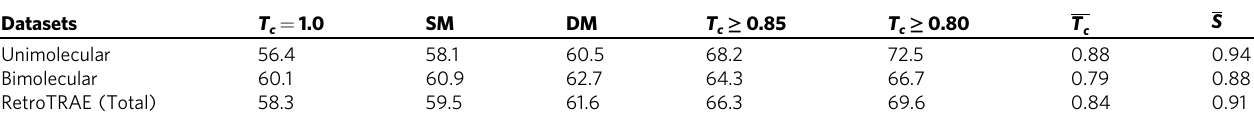
Table 2 The prediction accuracy (%) of RetroTRAE using x10 augmented uni- and bi- molecular reactions.